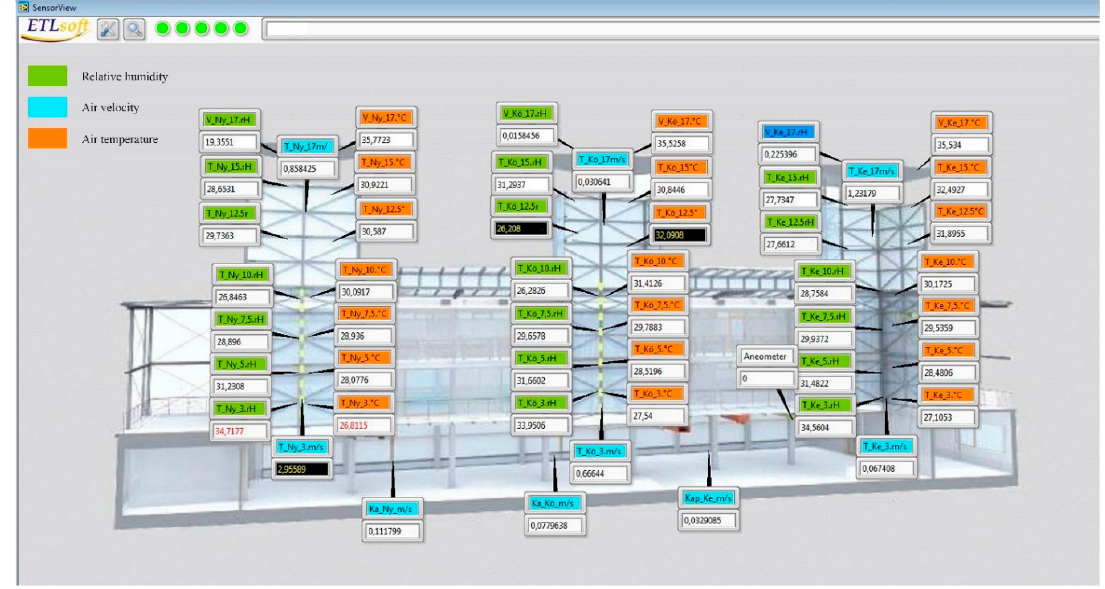
Figure 4. Software interface screen of the MMS monitoring system. Air temperature and relative humidity at different heights of the towers, airflow velocity at 3.5 and 17.0 m height of the towers, airflow velocity in the production hall and at façade gates.